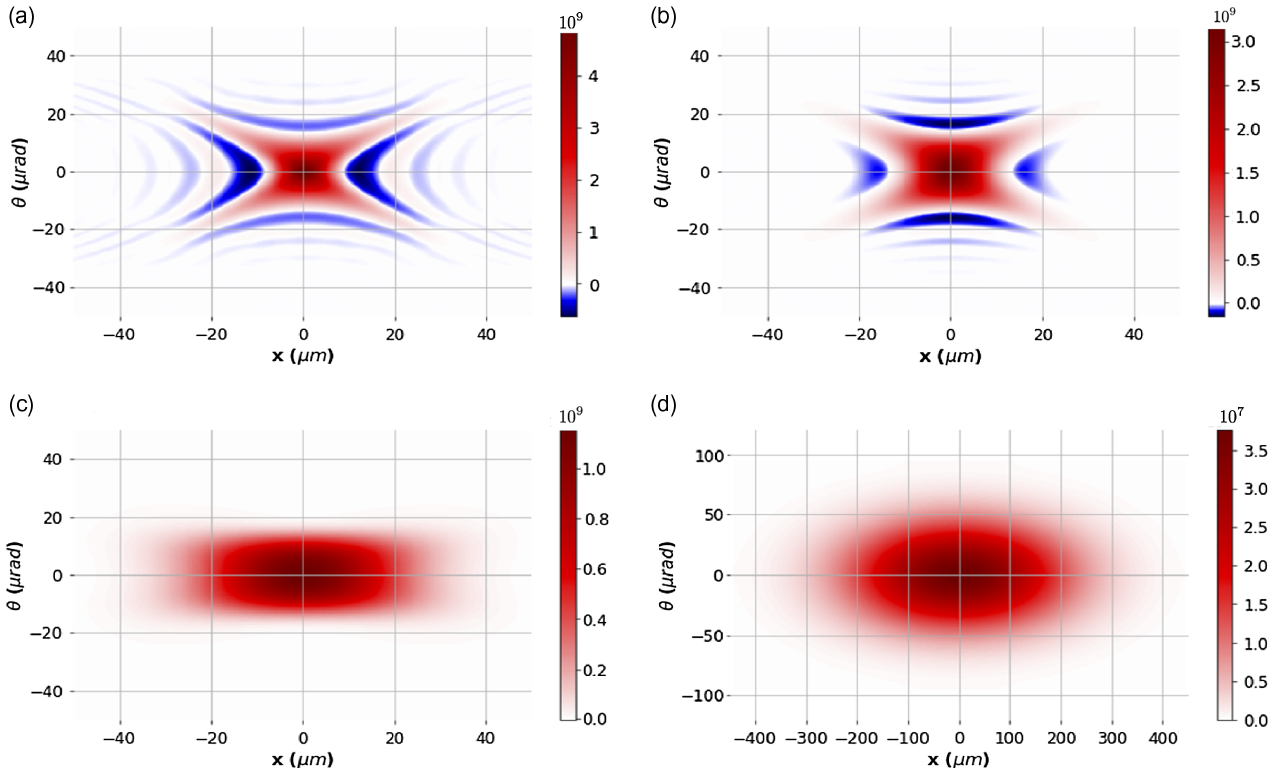
FIG. 9. Undulator radiation multielectron WFD for varying emittance ϵ : (a) zero emittance (fully coherent) (b) 4 pm (c) 40 pm (d) 4 nm.